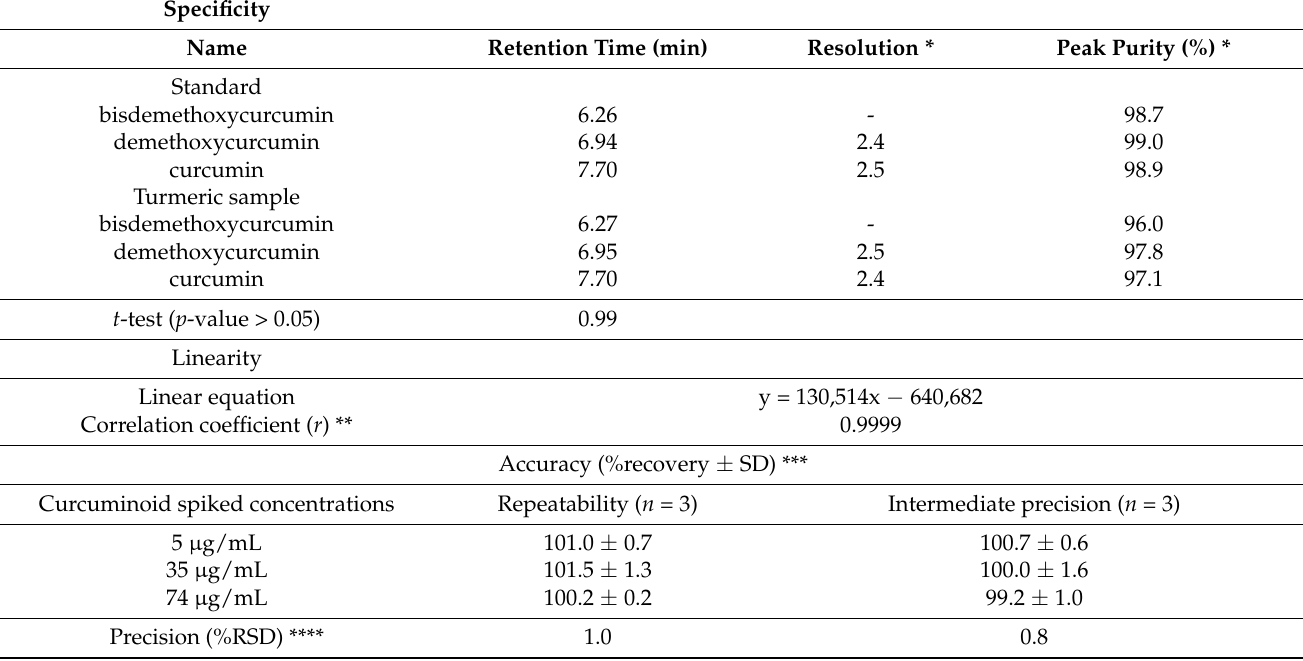
Table 1. The validation results of the HPLC